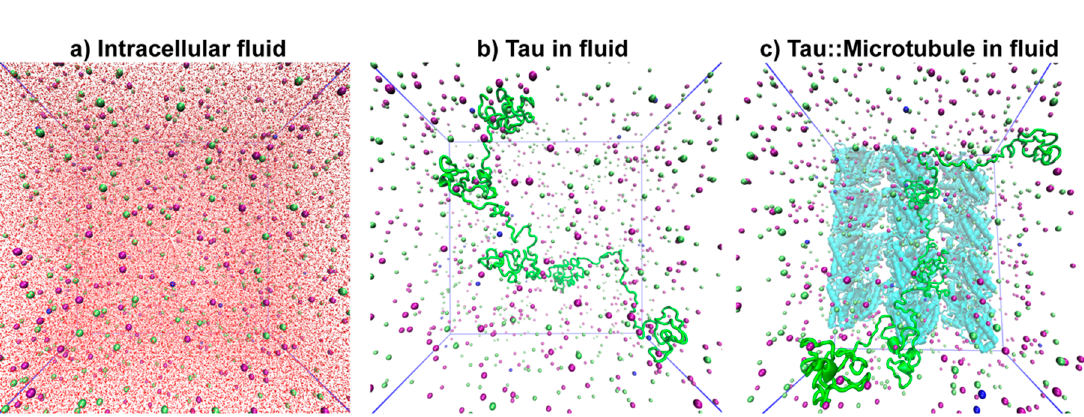
Figure 3. Front view snapshots of the systems under simulation: ( a ) Intracellular fluid, ( b ) tau in fluid, and ( c ) tau::microtubule wall in fluid. Water molecules were omitted in ( b ) and ( c ) to allow better visualization. Tau is represented in green, microtubule in cyan, K + in purple, Na + in blue, and Cl − in green spheres.